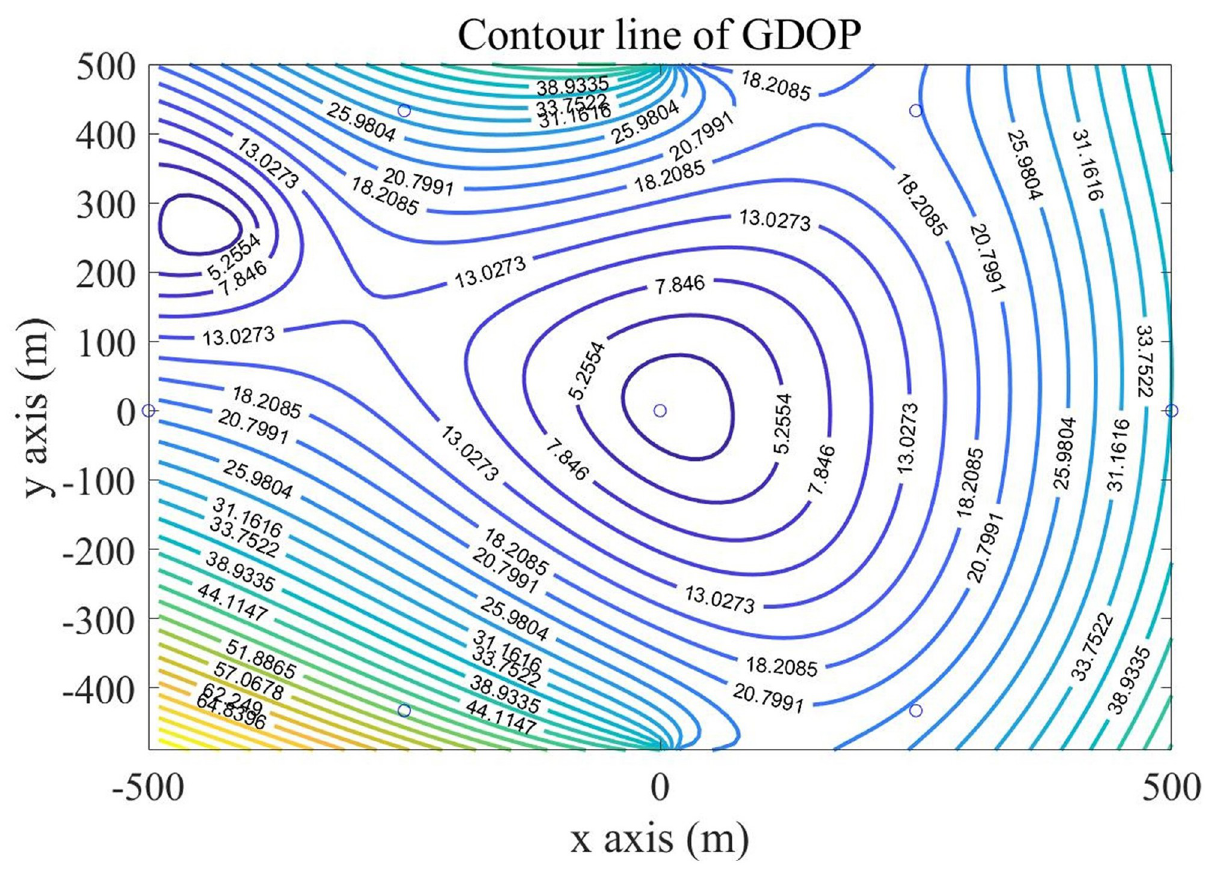
Fig 11. Contour lines of GDOP of four BSs using